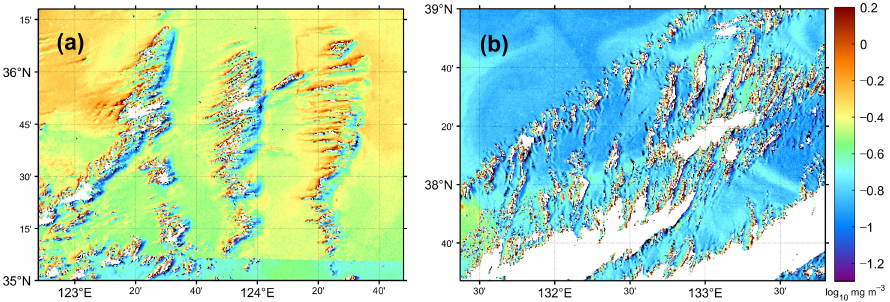
Figure 7. Example of erroneous chlorophyll- a concentration around clouds in the ( a ) Yellow and ( b ) East Sea on 3 June